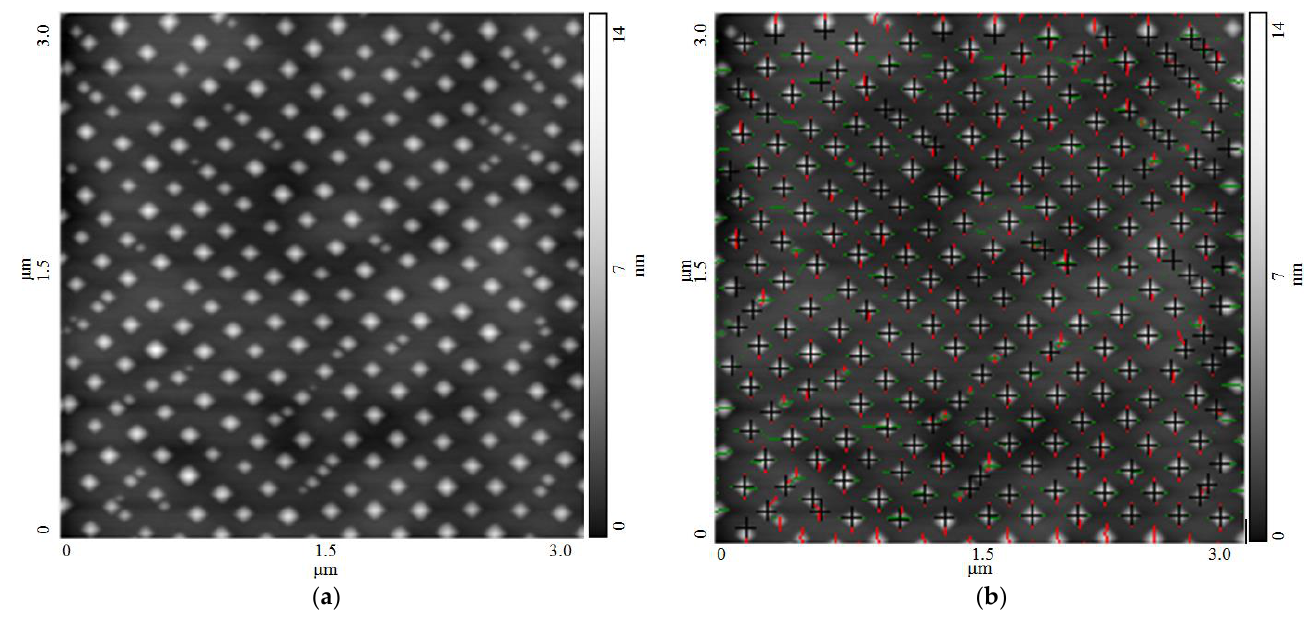
Figure 11. Array of ordered Ge(Si) pyramid islands, grown on relaxed SiGe buffer layer [46]: ( a ) source images 3 × 3 μ m; ( b ) images with marked centres.